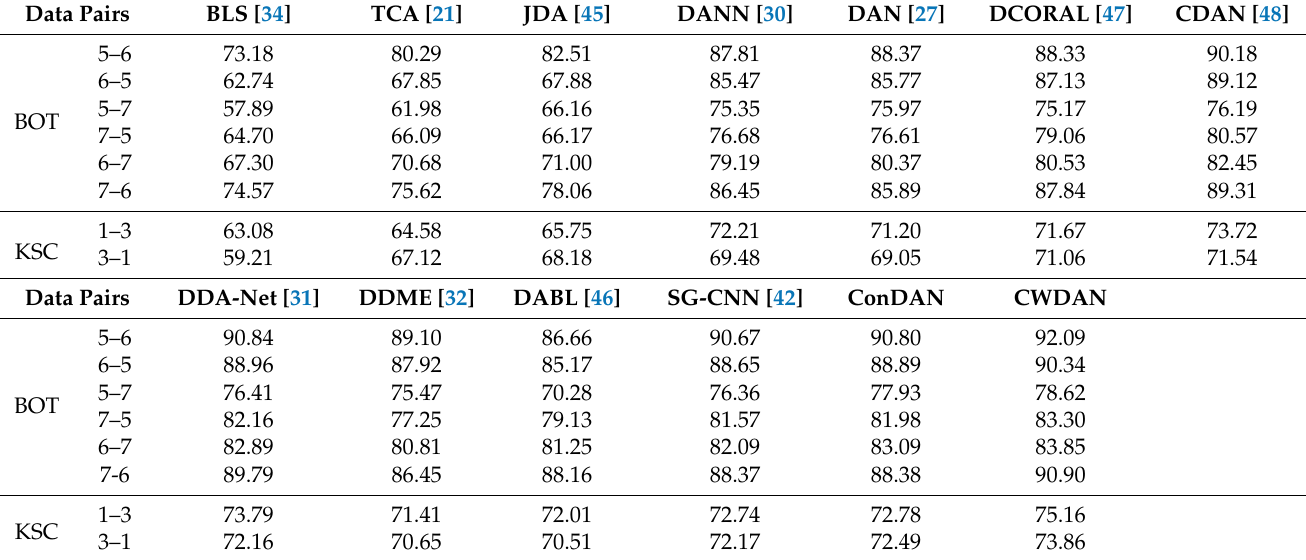
Table 3. Comparison of classification performance (OA, %).